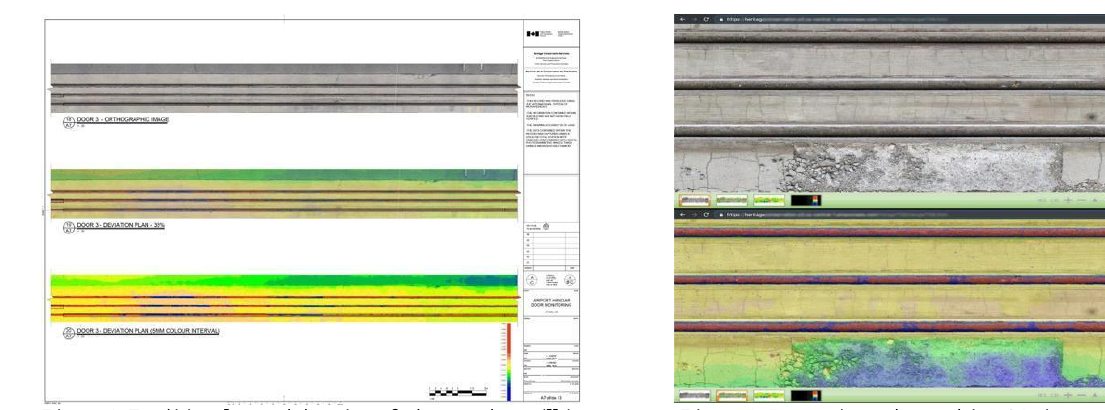
Figure 5: Interactive orthographic RGB image and related deviation map of the hangar door (from